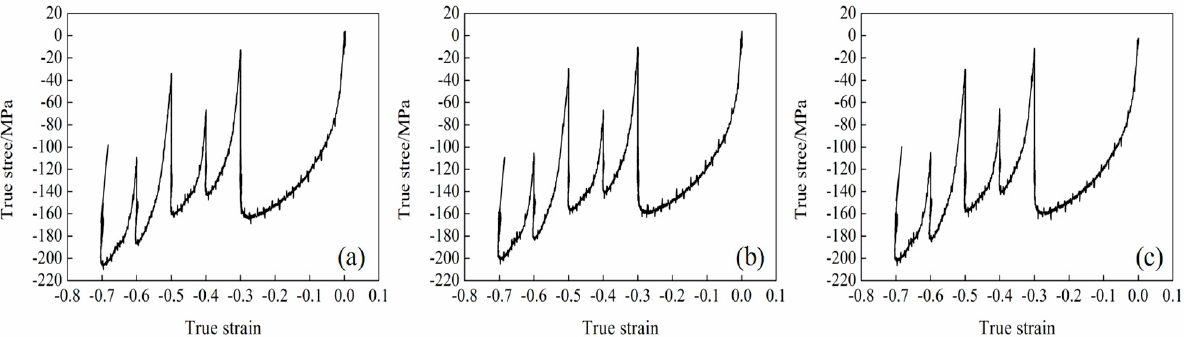
Figure 2. True stress − true strain curves of experimental steel at different final cooling temperatures after five passes of thermal simulation ( a ) 650 °C; ( b ) 700 °C; ( c ) 750 °C.